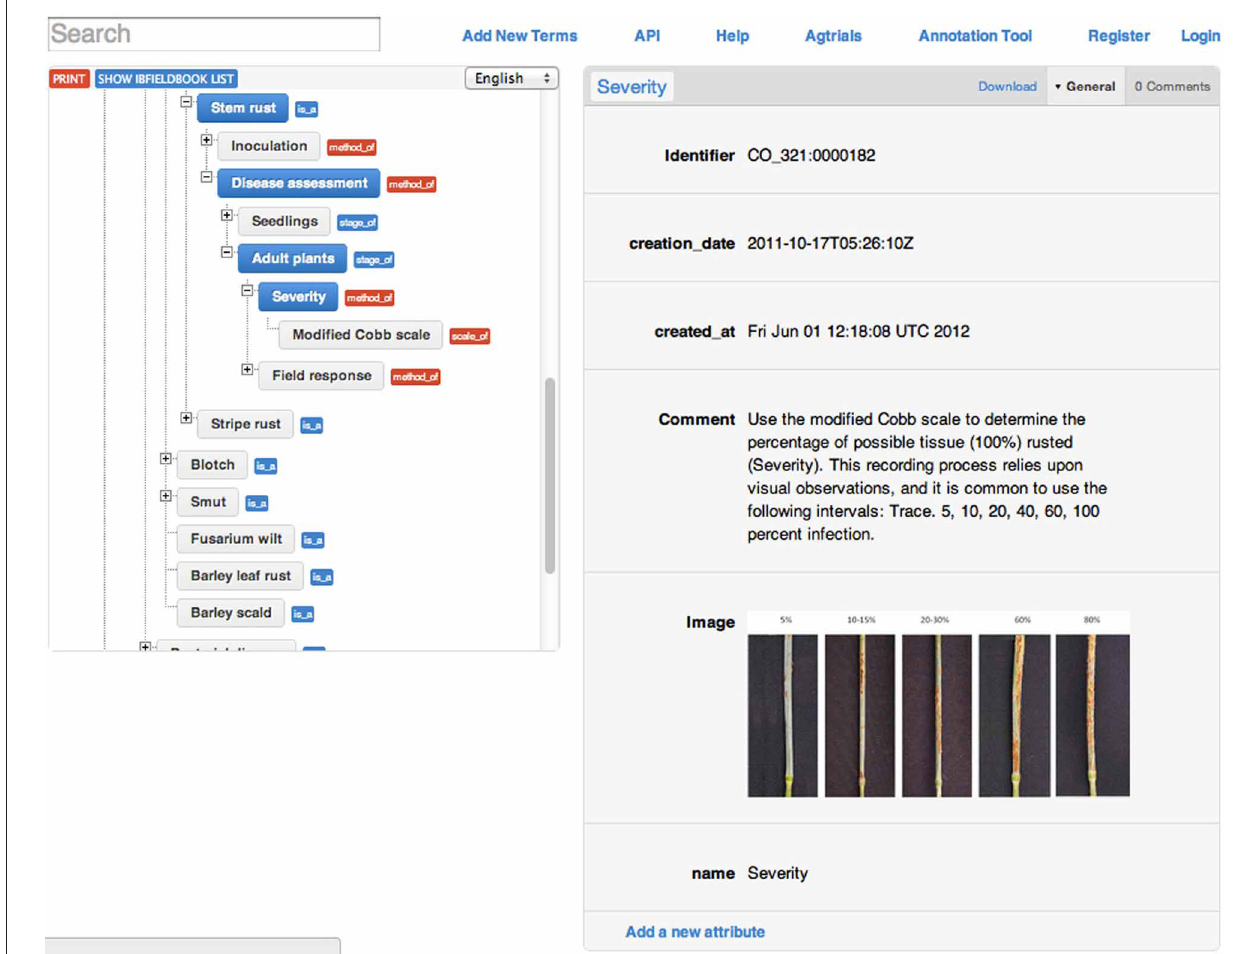
FIGURE 6 | Online display of new relationships “method_of” and “scale_of” for “stem rust” along with information and images about the scale used for